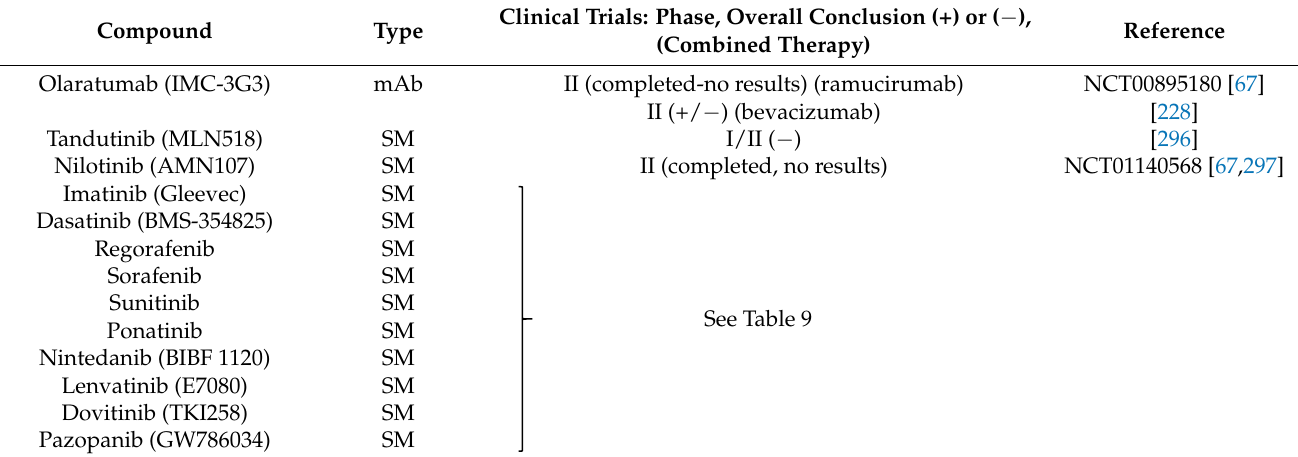
Table 6. Clinical trials in GB targeting the platelet-derived growth factor receptor.